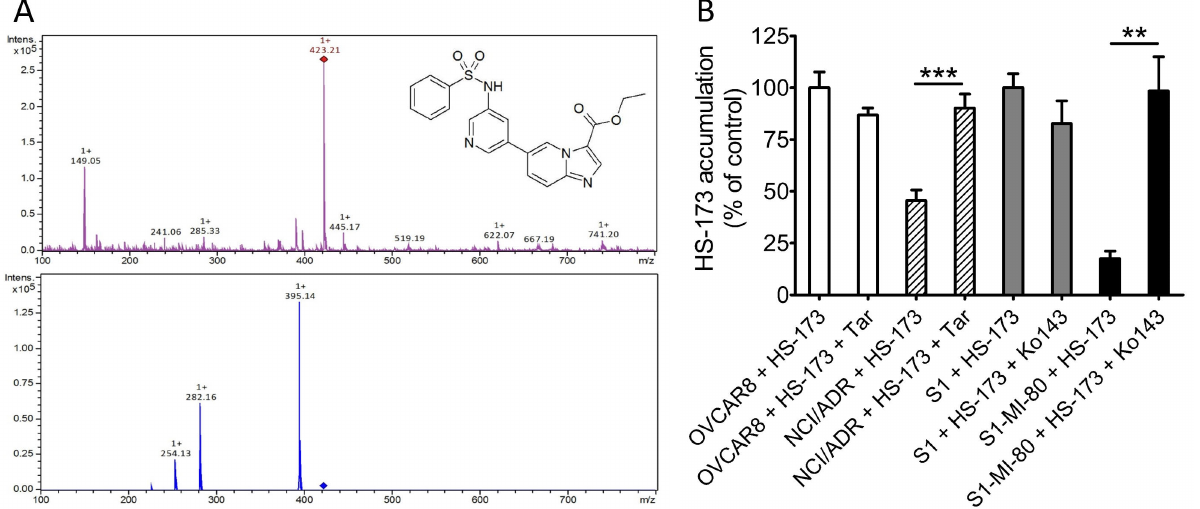
Figure 4. ABCB1- and ABCG2-mediated transport reduces the intracellular accumulation of HS-173 in human cancer cells. ( A ) The chemical structure and product ion mass spectra of HS-173 (precursor ion m / z 423.2 in positive mode). The fragment ion m / z 395.1 was selected for quantitative analysis. ( B ) Quanti fi cation of intracellular concentration of HS-173 by HPLC-MS/MS analysis in drug-sensi- tive OVCAR-8 cells (open bars), ABCB1-overexpressing NCI-ADR-RES (striped bars), drug-sensi- tive S1 (gray bars), and ABCG2-overexpressing S1-MI-80 (black bars) cells with or without the ad- dition of 10 µM tariquidar or Ko143 as described in the Materials and Methods section. Values are mean values ± SD calculated from more than three independent experiments. ** p < 0.01 and *** p < 0.001 versus the treatment with tariquidar or Ko143.